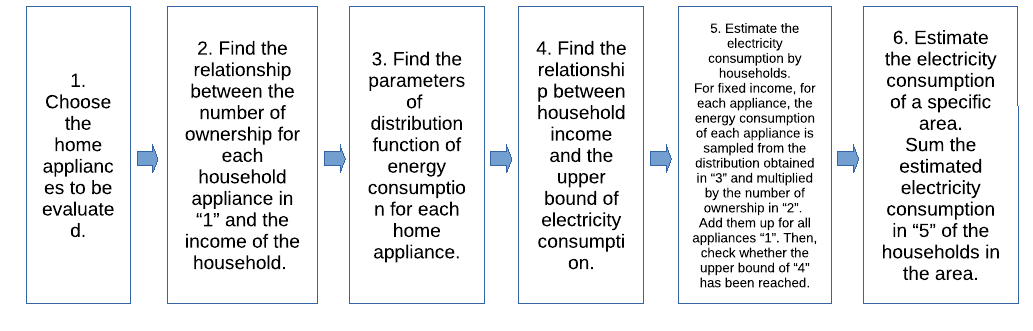
Figure 1. Flowchart of the